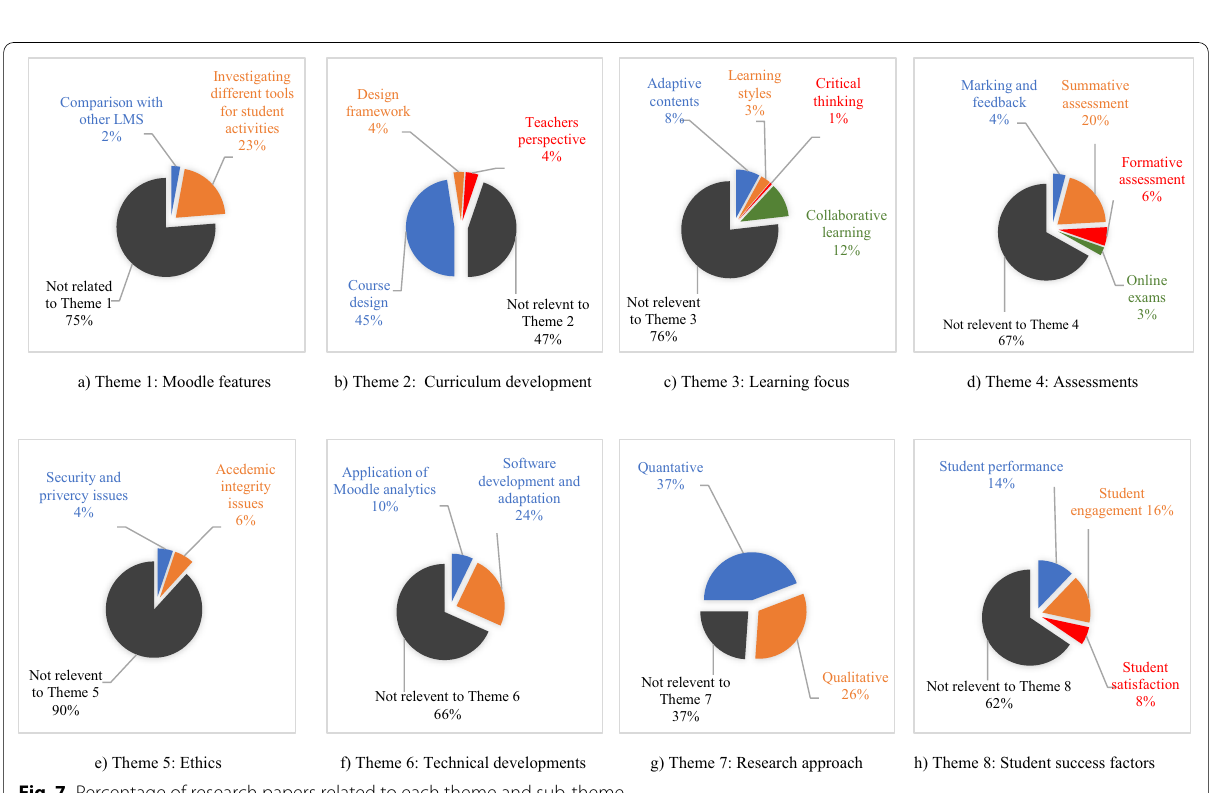
Fig. 7 Percentage of research papers related to each theme and